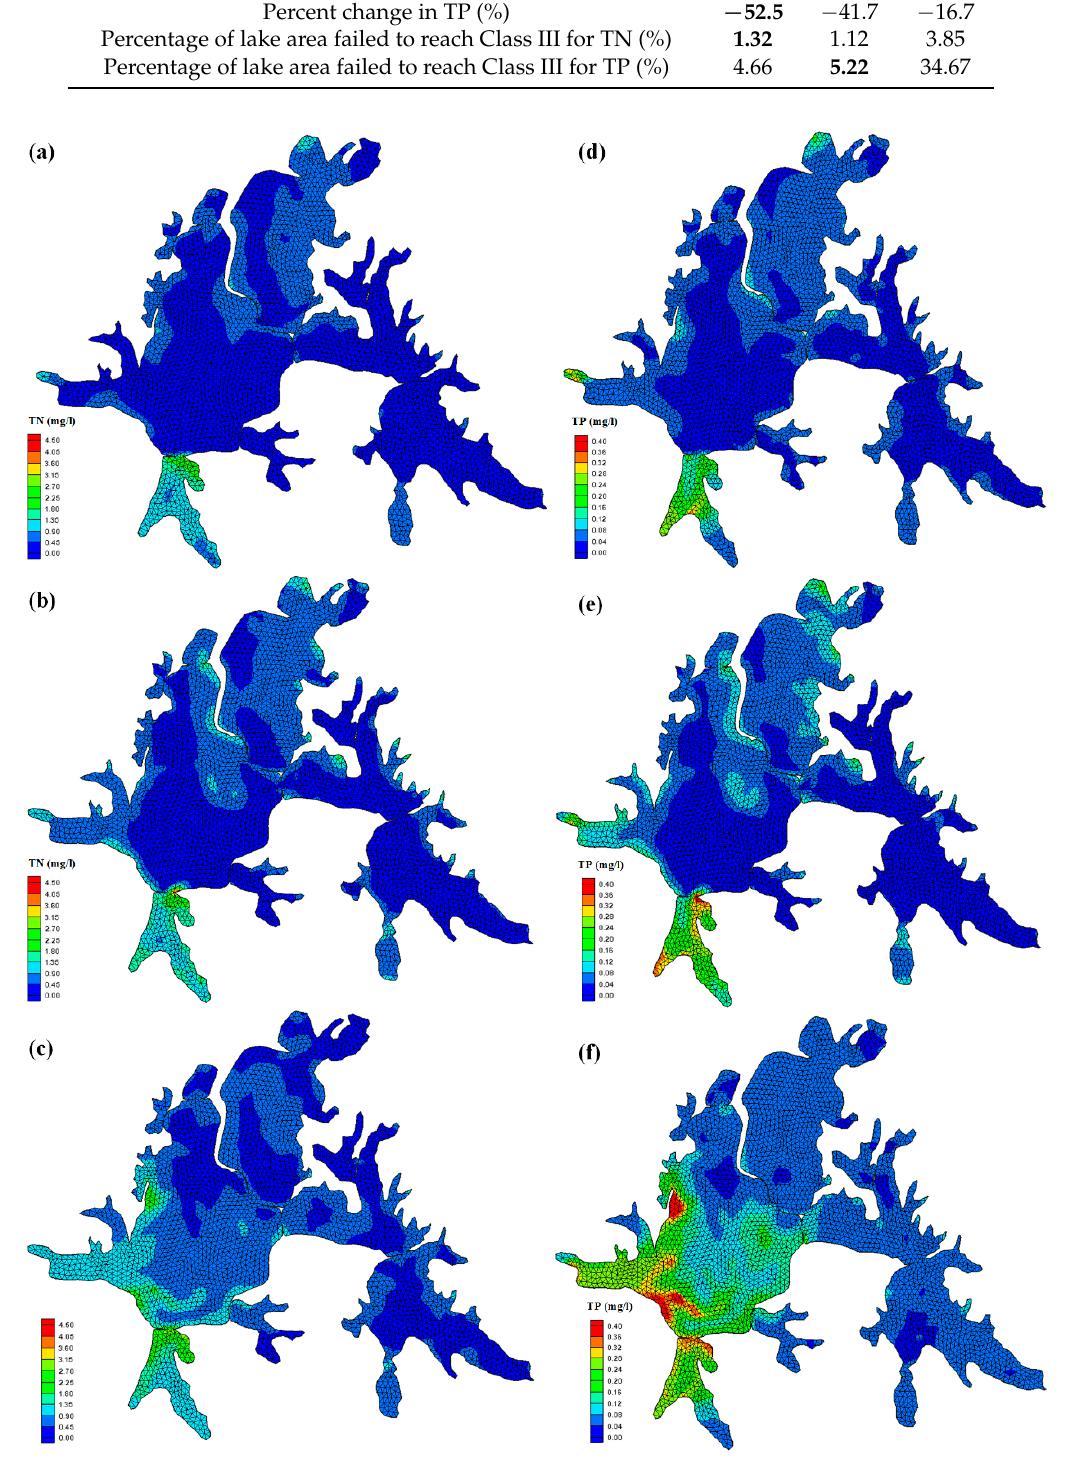
Figure 13. ( a – c ): spatial distribution of TN under scenarios S1, S2, and S3; ( d – f ): spatial distribution of TP under scenarios S1, S2, and S3.